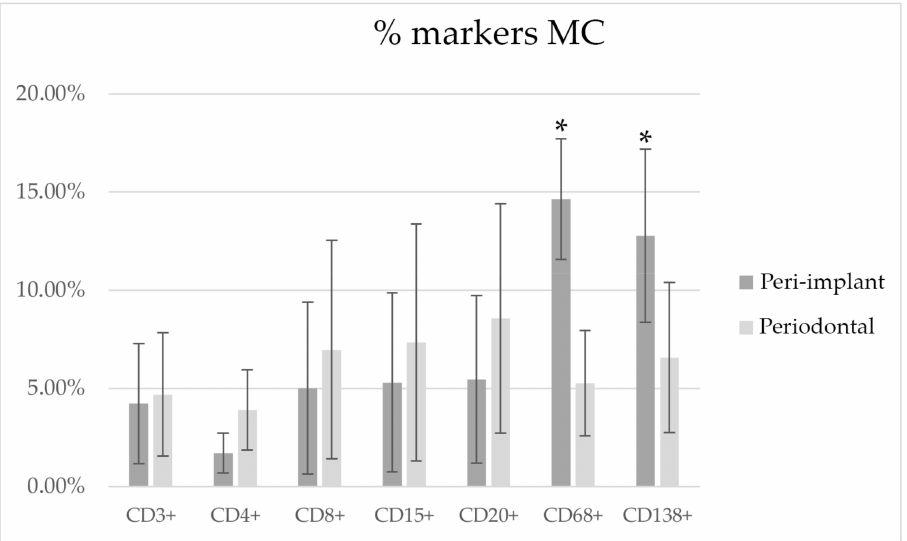
Figure 6. Markers counted with the MC technique. * Statistical difference evidenced between groups ( p < 0.05).